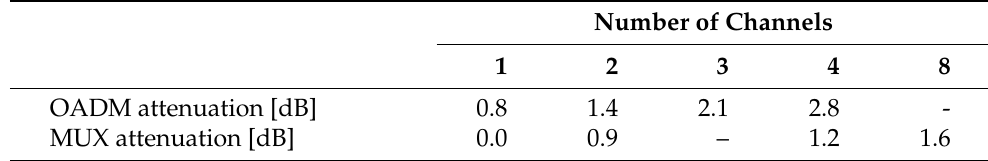
Table 3. Attenuation of OADMs and MUXs; the values do not comprise connector losses.